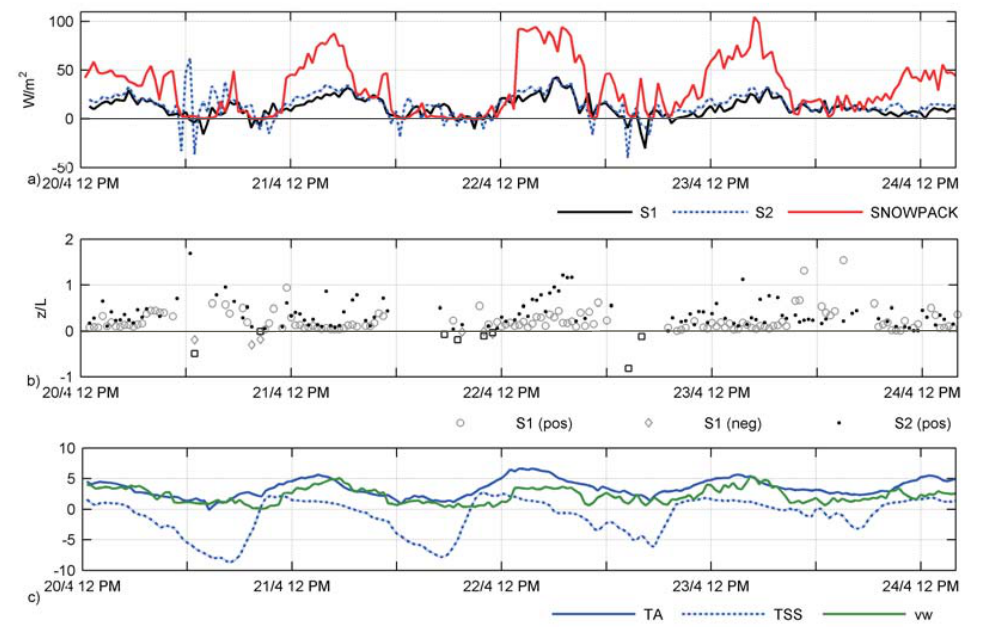
Fig. 10. Time series of measured turbulent heat fluxes ( Q s ) at Sonic 1 (S1) and Sonic 2 (S2), and modeled heat fluxes (SNOWPACK) for time period 20–24 April 2007 (a) . Time series of z/L ( L = Obukhov length, z = instrument height) at Sonic 1 (S1), located 4m above ground and Sonic 2 (S2), at 2m above (b) . Note that different symbols are used for positive and negative z/L indicating statically stable and statically unstable. Air temperature (TA), snow surface temperature (TSS) and wind velocity (vw) measured at the weather station are also shown (c) for the same time period. Note that atmospheric stability is enabled for SNOWPACK runs.